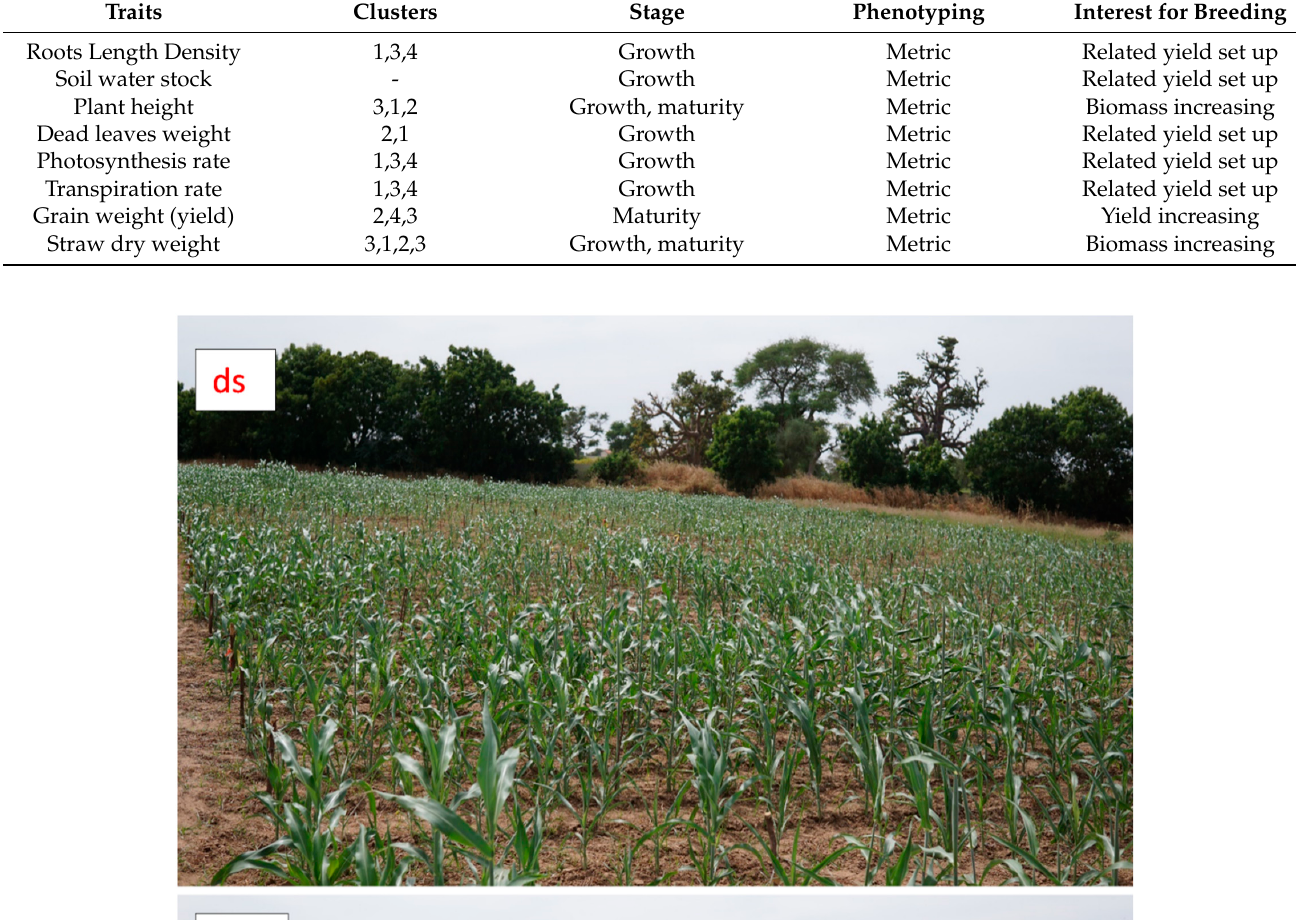
Table 7. The key traits involved in clusters classification, their technique and stage to phenotype under early water deficit in sorghum and their interest for breeding.